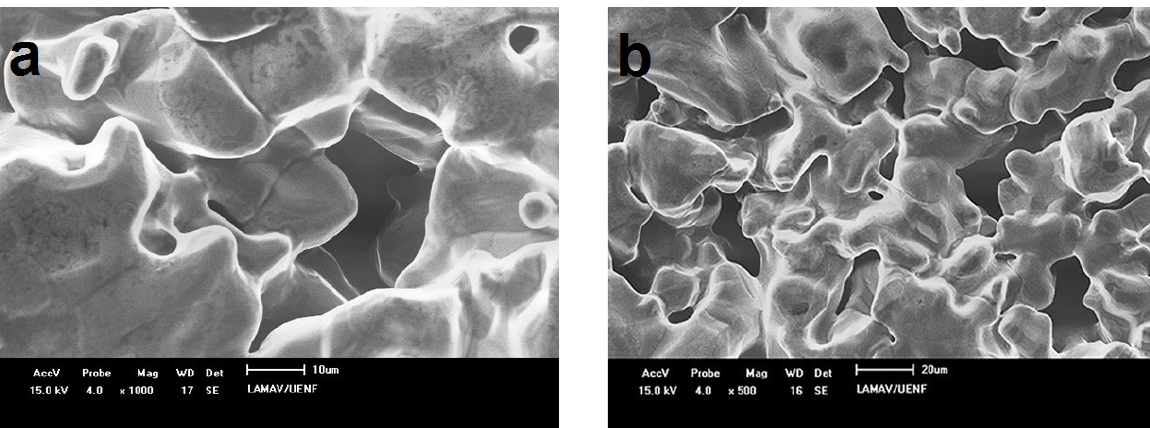
Figure 4 - Micrograph evidencing a pore on the surface of Ti at 1000x magnification ( a ). Distribution of pores on the surface of the material ( b